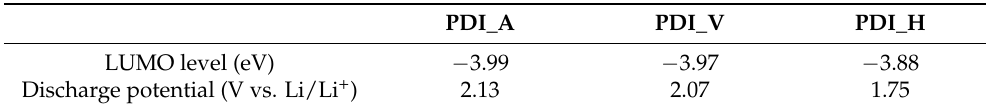
Figure 1. Cyclic voltammetry (CV) curves of ( a ) PDI_A, ( c ) PDI_V, and ( e ) PDI_H at 10 mVs − 1 in a potential range of 1.0 V–4.0 V vs. Li/Li + . Galvanostatic charge–discharge profiles of ( b ) PDI_A, ( d ) PDI_V, and ( f ) PDI_H at 50 mAg − 1 . Table 1. Relationship between the discharge potential and the LUMO